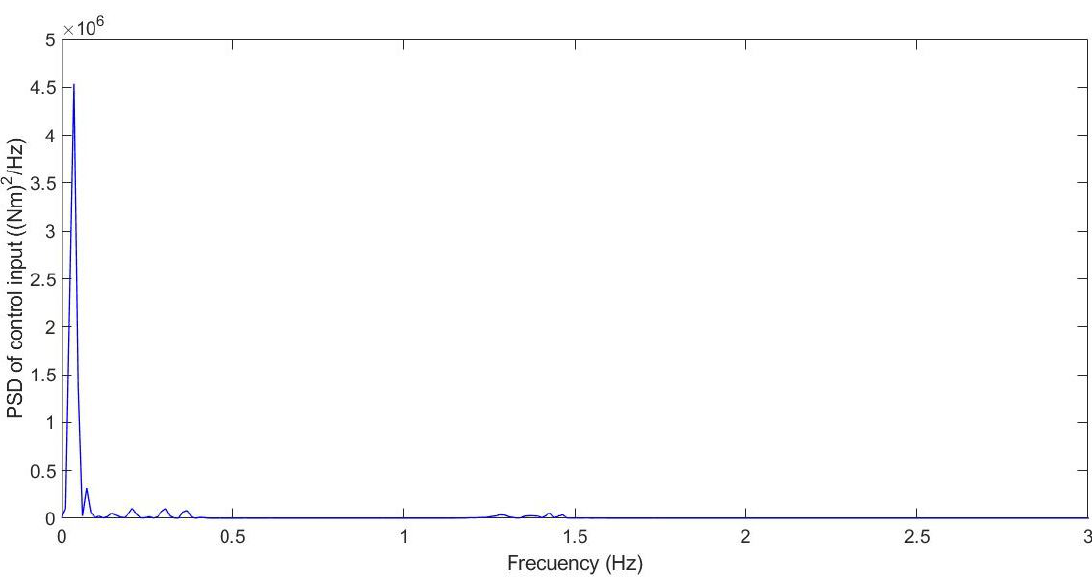
Figure 19. Frequency response for test 2: Double lane change at 100 km/h.